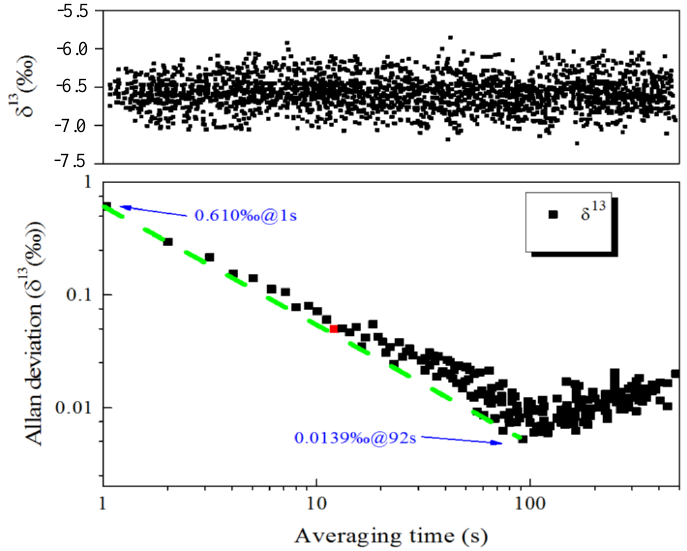
Figure 8. Long-term measurement of a configured concentration of 500 ppmv CO 2 and the measured Allan deviation analysis 13 δ based on the data.